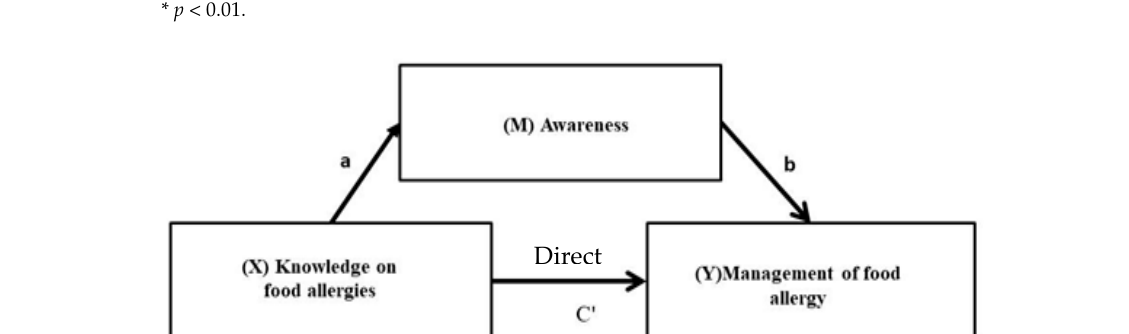
Figure 2. The influence of knowledge of food allergies on management of food allergy mediated by awareness.